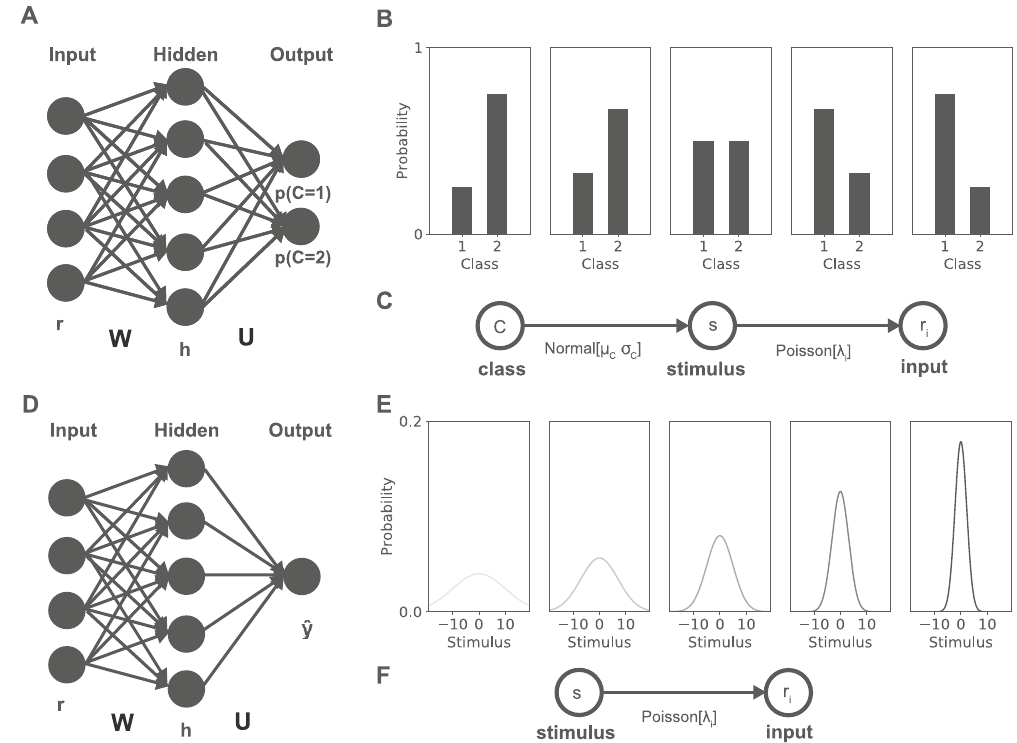
Figure 1. Neural population model and task overview. Two different tasks were studied, a classification task (top row) and a stimulus estimation task (bottom row). The neural network for the classification task and estimation task had a similar input and hidden layer, only the output layer differed. (A) Two softmax outputs (one for each class) indicated the probability that the stimulus observed came from the respective class in the classification task. (B) The stimuli from each class came from a normal distribution with a mean and variance specific to that class. Different prior probabilities for the classes were tested as represented by the bars. (C) The generative model used to generate a stimulus from a selected class and subsequently generate firing rates for the input Poisson neurons. (D) A single output indicated the estimated stimulus value in the estimation task. (E) The stimuli presented to the network were drawn from a normally distributed prior. Priors with different 100, 50, 25, 10, 5 variances were tested: σ 2 s (indicated by gray scale, from left to right). (F) The generative ∈ { } model for the estimation task, used to generate firing rates for the input Poisson neurons from a generated